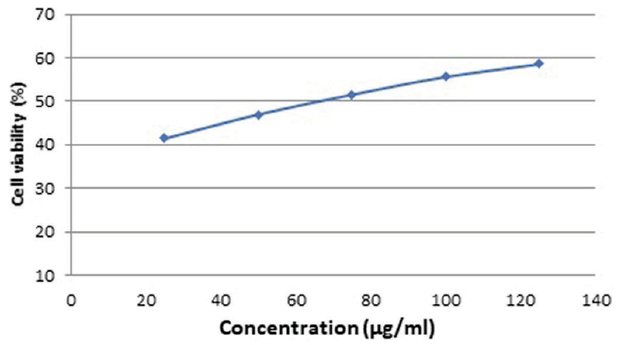
concentration of acetone extract of 50